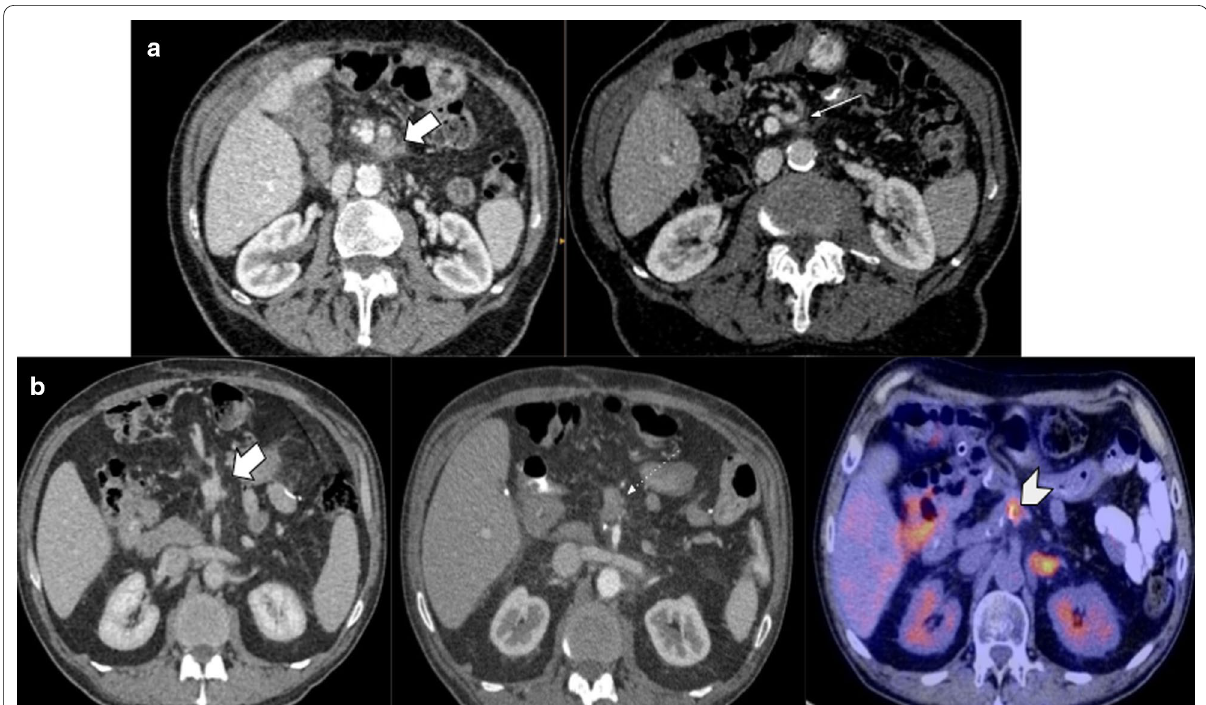
Fig.12 Perivascular cuffing vs. tumor recurrence. CT challenge. Two different patients ( a ) 81-year-old male patient three weeks after pancreaticoduodenectomy due to ampulloma. ( b ) 45-year-old male patient with fever 21 days after pancreaticoduodenectomy due to adenocarcinoma. Soft-tissue imaging in the surgical bed (thick white arrows), in both cases strict follow-up was required. In patient A, the focal fat stranding has markedly resolved (thin arrow): while in patient B persists without significant change after a year (dotted arrow). PET/CT shows hypercaptation mass, which confirms tumor recurrence